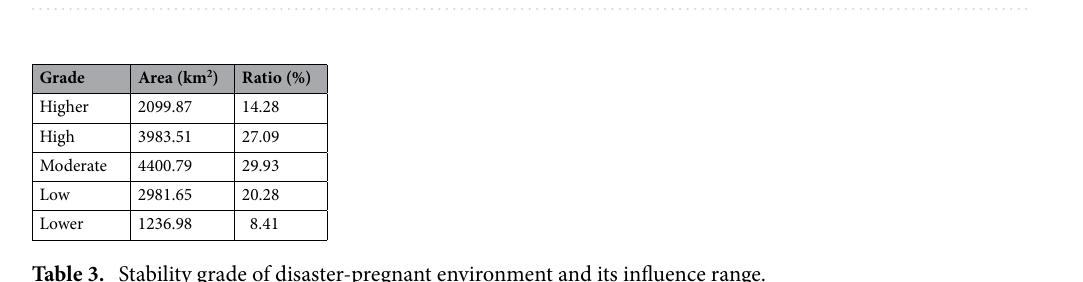
Figure 5. Distribution pattern of flood disaster-pregnant environment stability in Lijiang River Basin.